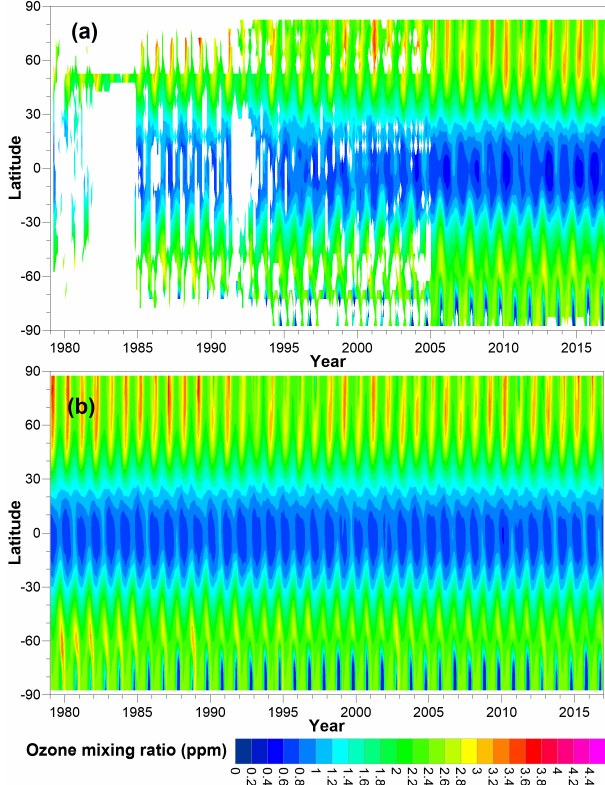
Figure 5. Monthly mean zonal mean ozone mixing ratios at 20km for (a) unfilled adjusted ozone values from different data sources (Tier 0) and (b) pre-filled (Tier 0.5) ozone database. For more de- tails see